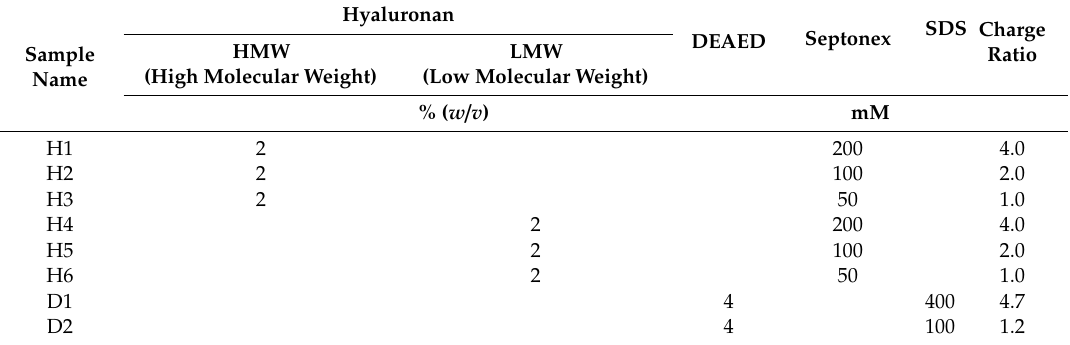
Table 1. Concentrations of initial solutions of hyaluronan (HYA), DEAED (Diethylaminoethyl-dextran hydrochloride), Septonex and SDS (Sodium dodecyl sulphate) used to prepare hydrogels by the solution